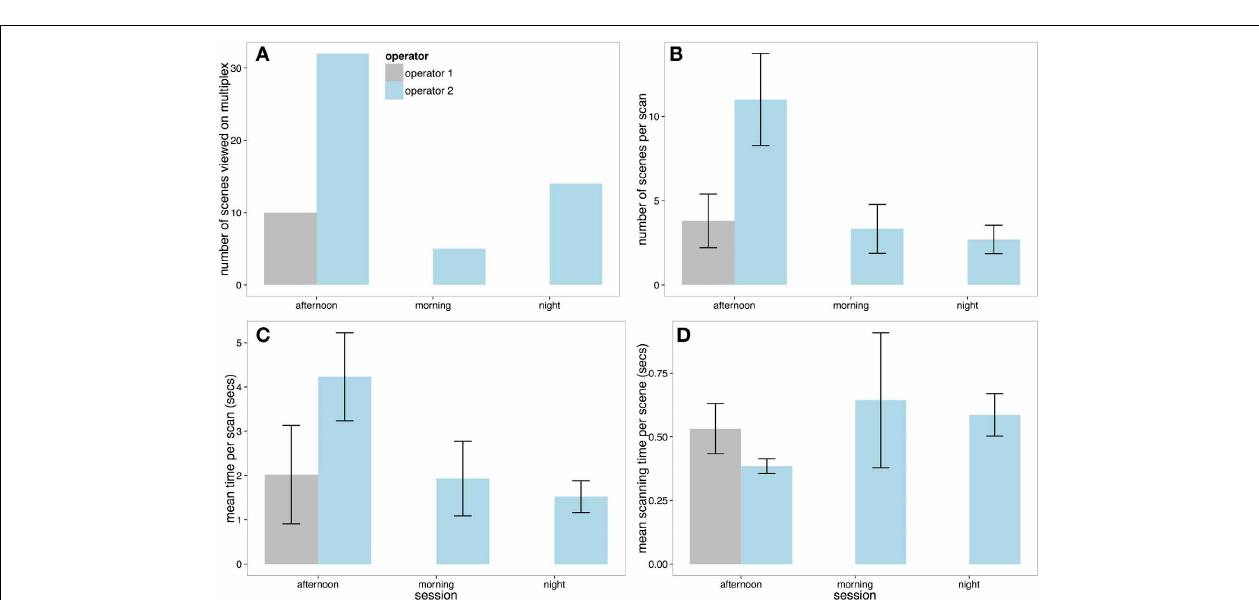
and represent that Kullback-Leibler divergence analysis gives two scores for each comparison (the probability of distribution A/B, and the probability of distribution B/A).